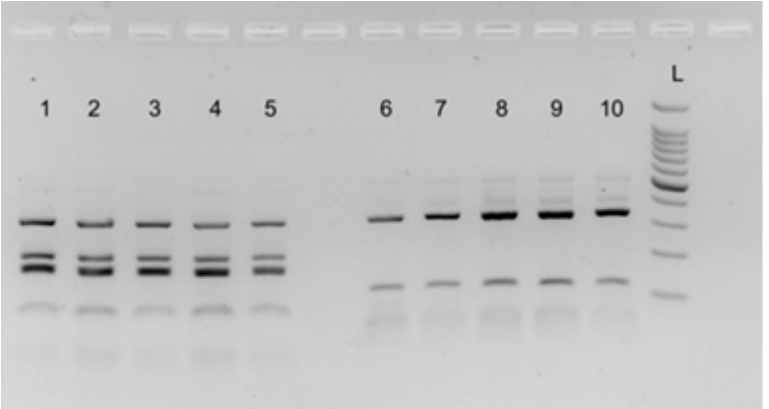
Figure 3. A representative gel displaying the Restriction Fragment Length Polymorphism profiles of C. rudolphii A obtained after digestion of ITS amplicons with endonuclease Tsp509 I (lanes 1–5) and of rrnS amplicons with Rsa I (lines 6–10). L: molecular ladder 100 bp (500 bp lane is highlighted).